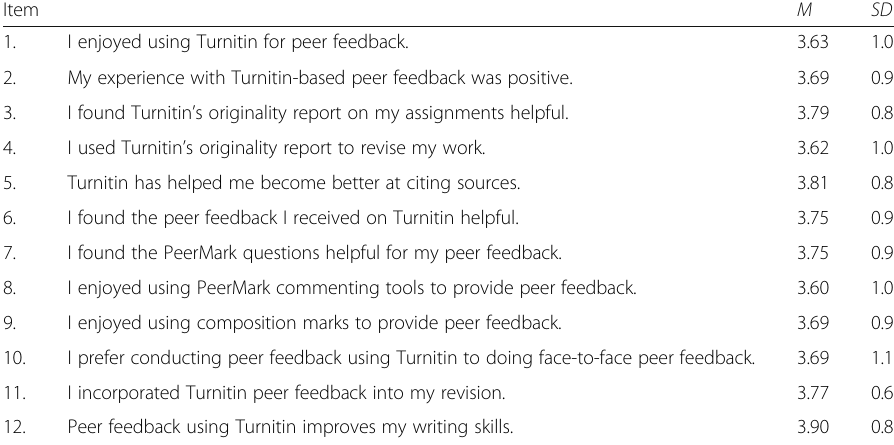
Table 4 Means and standard deviation of the questionnaire items (adapted from Li & Li, 2017)